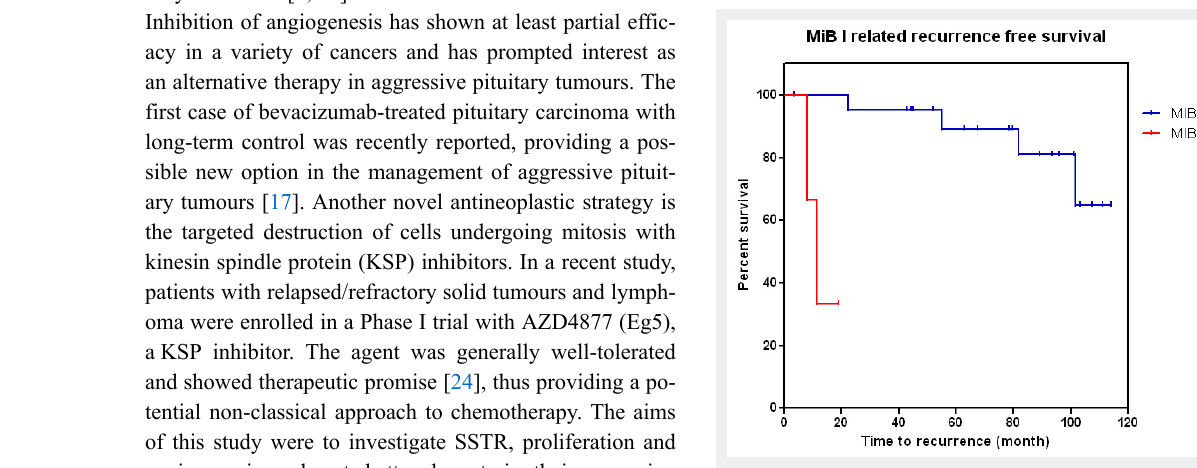
Figure 3 Kaplan-Meier curve showing MIB-1 (Ki-67) proliferation index and time to recurrence: cases with higher MIB-1 proliferation index are more likely to recur (p